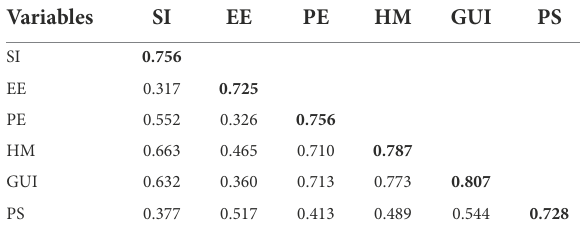
TABLE 3 Correlations of